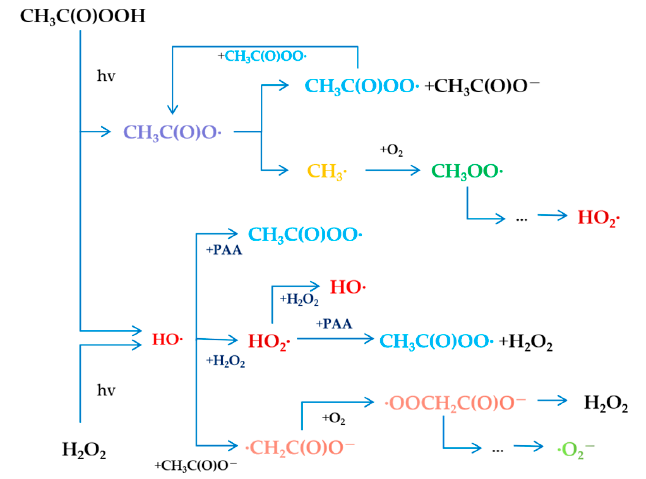
Figure 2. UV/PAA reaction scheme. Reprinted with permission from Ref. [67]. 2020, Tianqi Zhang, Ching-Hua Huang